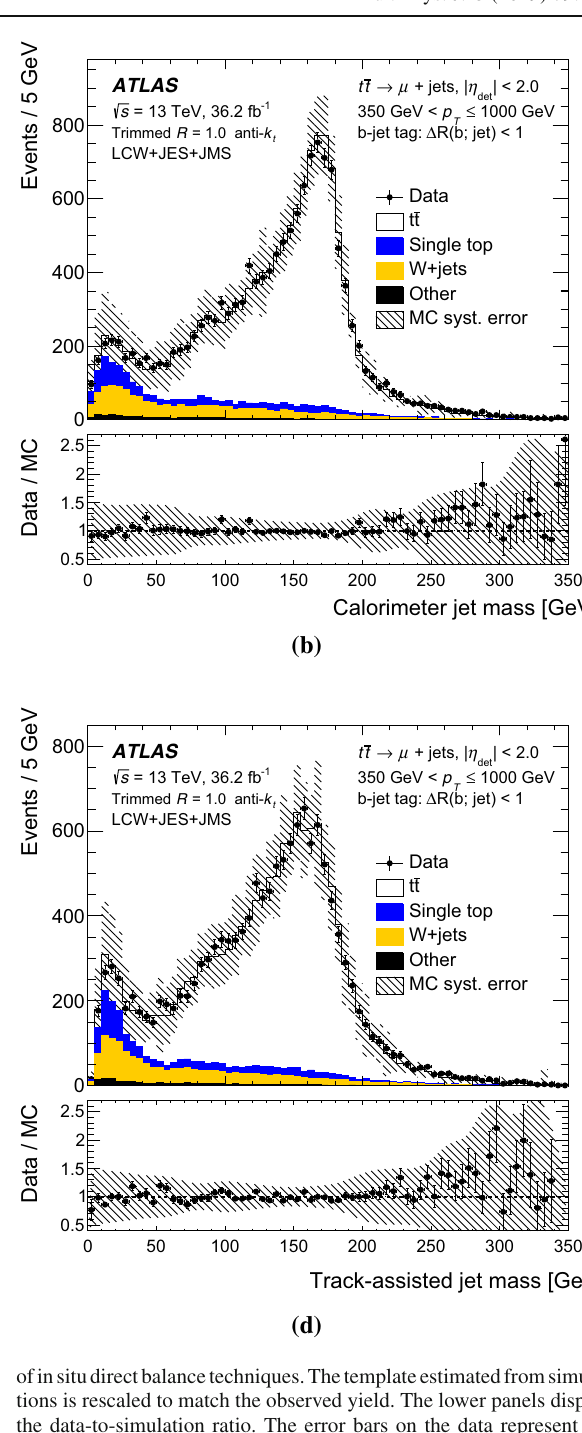
ofinsitudirectbalancetechniques.Thetemplateestimatedfromsimula- tions is rescaled to match the observed yield. The lower panels display the data-to-simulation ratio. The error bars on the data represent the statistical uncertainty. The dashed uncertainty band on the simulation templateincludesthesystematicuncertaintiesduetosignalanddetector